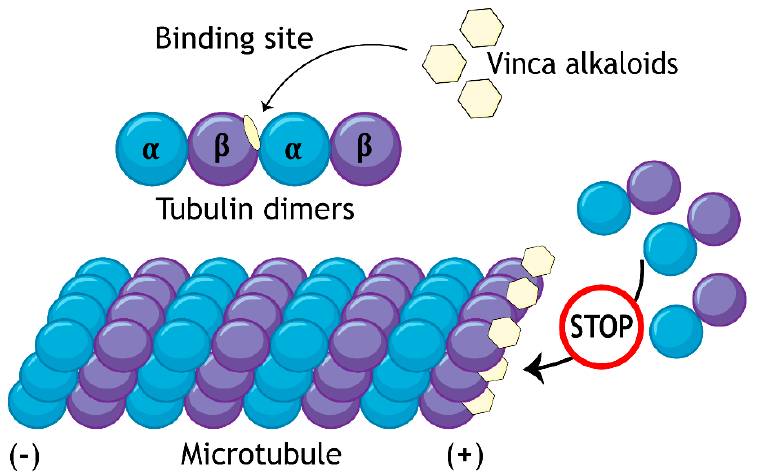
Figure 2. Vincristine binds the β -subunit of a tubulin dimer on the boundary with a neighboring dimer and, thus, stabilizes the microtubule dynamics by preventing binding free tubulin dimers to the microtubule fiber.